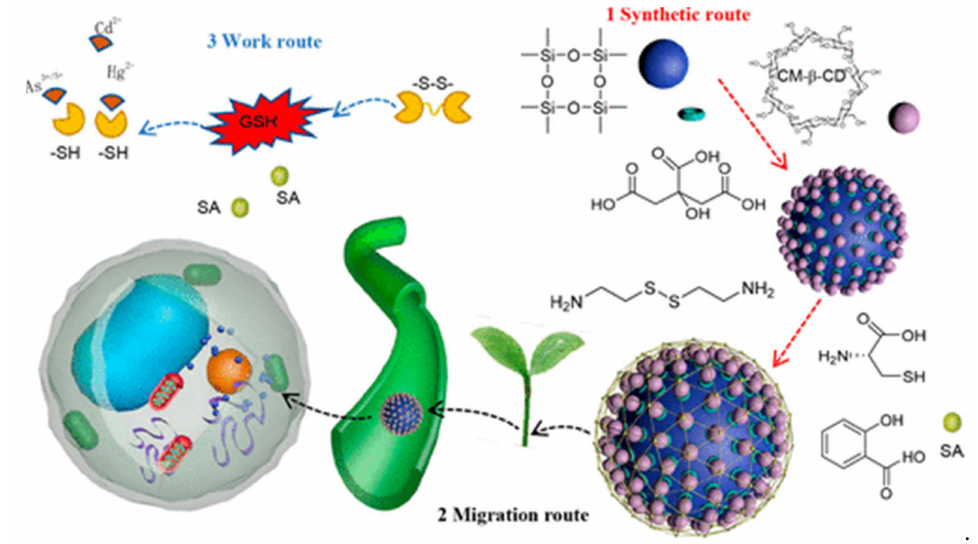
Figure 4. Schematic of the process of releasing hormones and adsorbing heavy metal ions induced by a dual-functional redox-responsive nanocarrier (reprinted from [105] with permission from the American Chemical